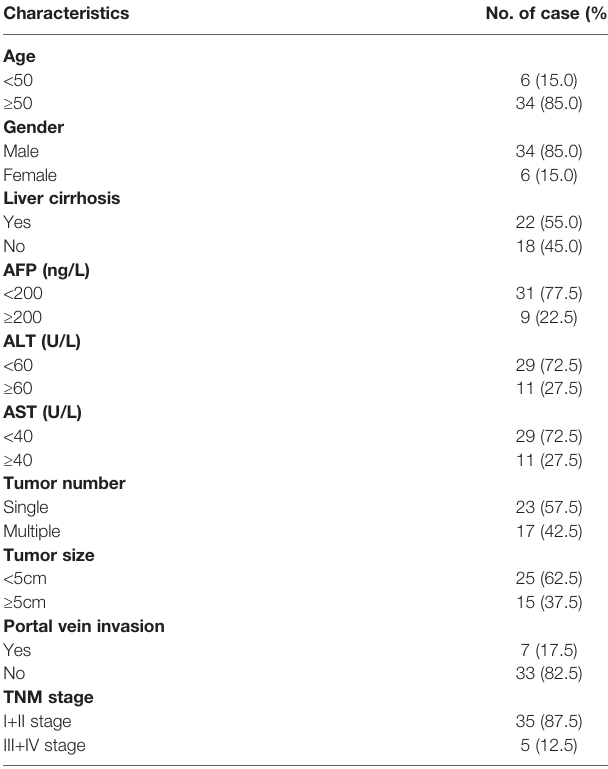
TABLE 1 | Clinicopathological characteristics of patient samples and expression of DTYMK in HCC.